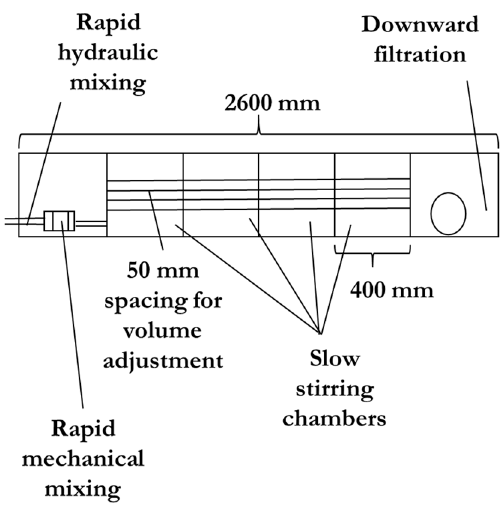
Figure 3. Water Treatment Plant with downward filtration (top view); rapid mixing chamber (net